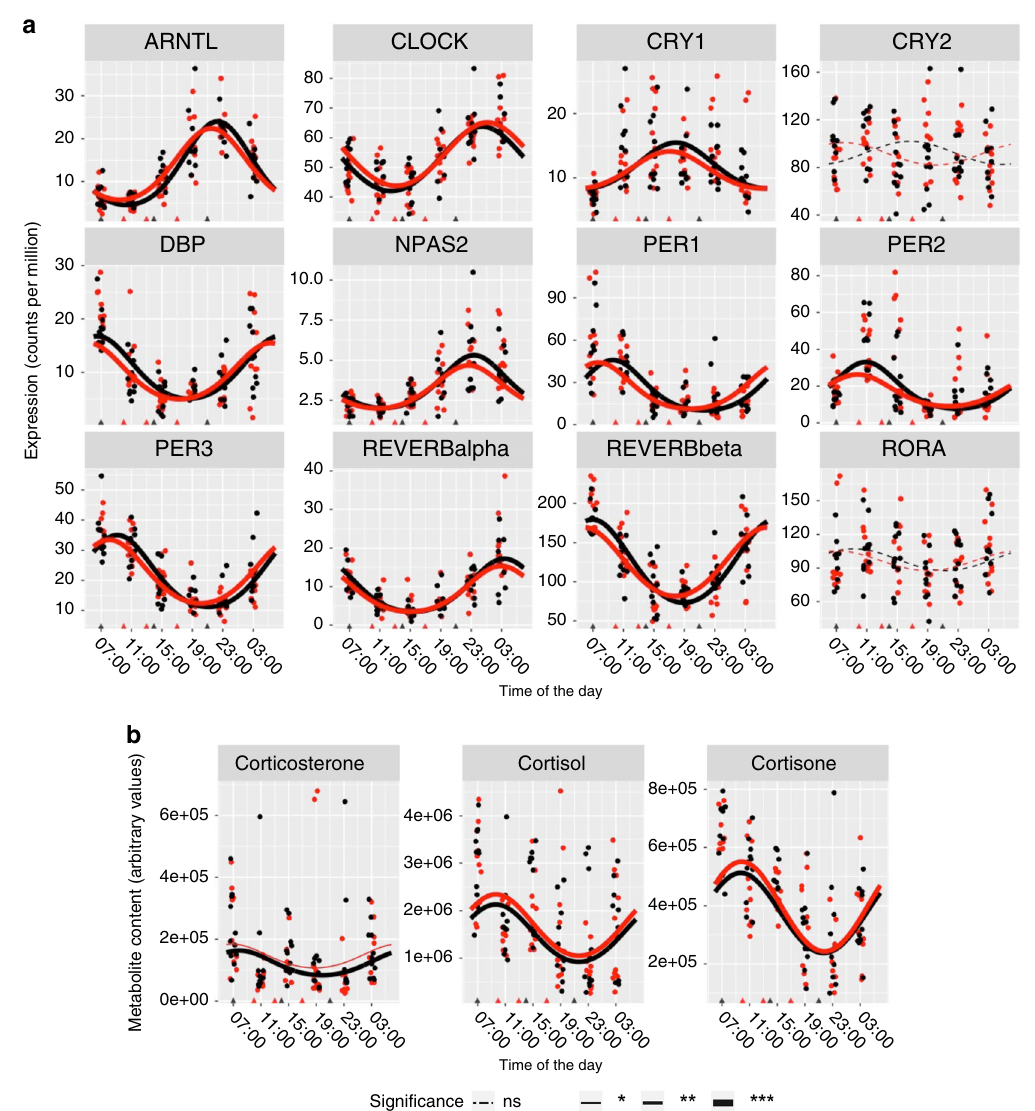
Fig. 5 Periodicity of clock machinery. Expression of core clock genes in skeletal muscle ( a ) and corticosteroids in serum ( b ). Black line color indicates extended feeding (EXF), and red line color indicates time-restricted feeding (TRF). Points are individual datapoints, and lines represent cosinor regression fi t. Triangle indicates feeding time, line type indicates FDR adjusted, RAIN derived p value for either EXF, or TRF; ns p > 0.05, * p < 0.05, ** p < 0.01, *** p < 0.001, n = 11